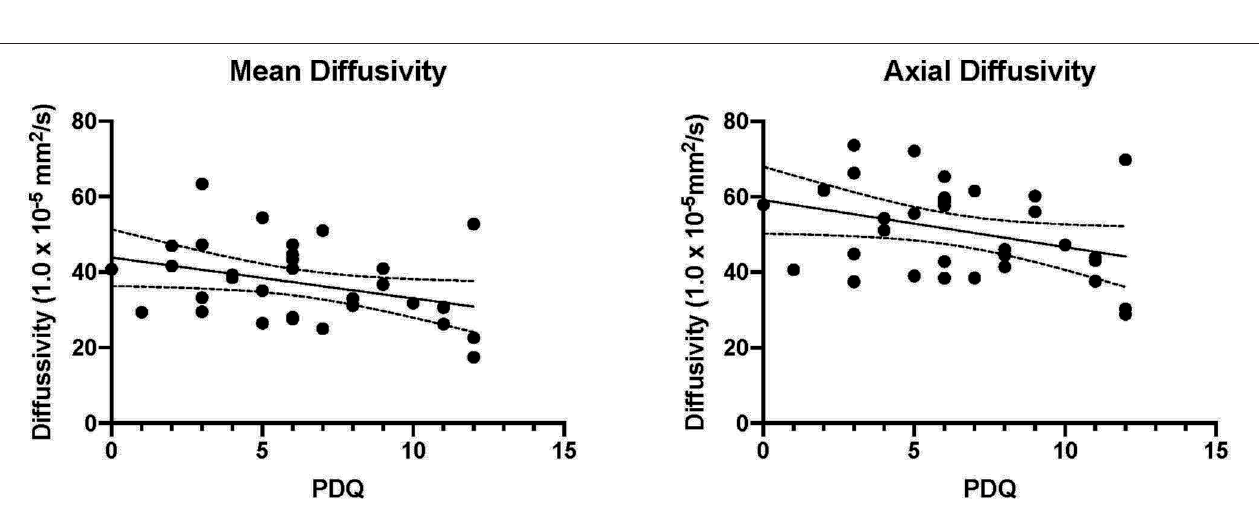
FIGURE 4 | Correlations between pain reporting and imaging. The significant correlations are plotted between axial and mean diffusivity of the injured fibular nerve. PDQ, Pain Detection